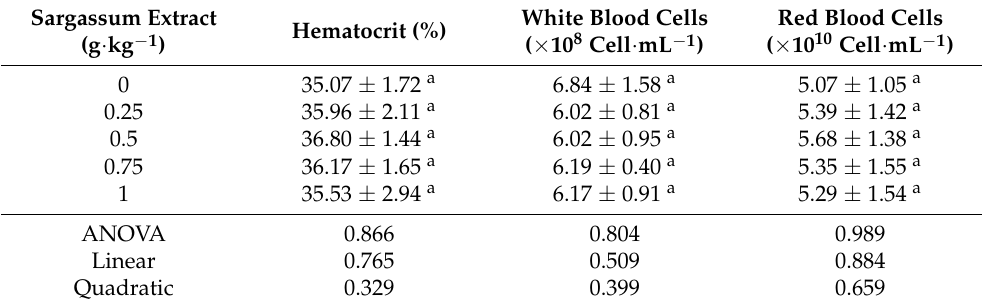
Table 5. Hematocrit, white and red blood cell counts in spotted scat fed the experimental diets for 8